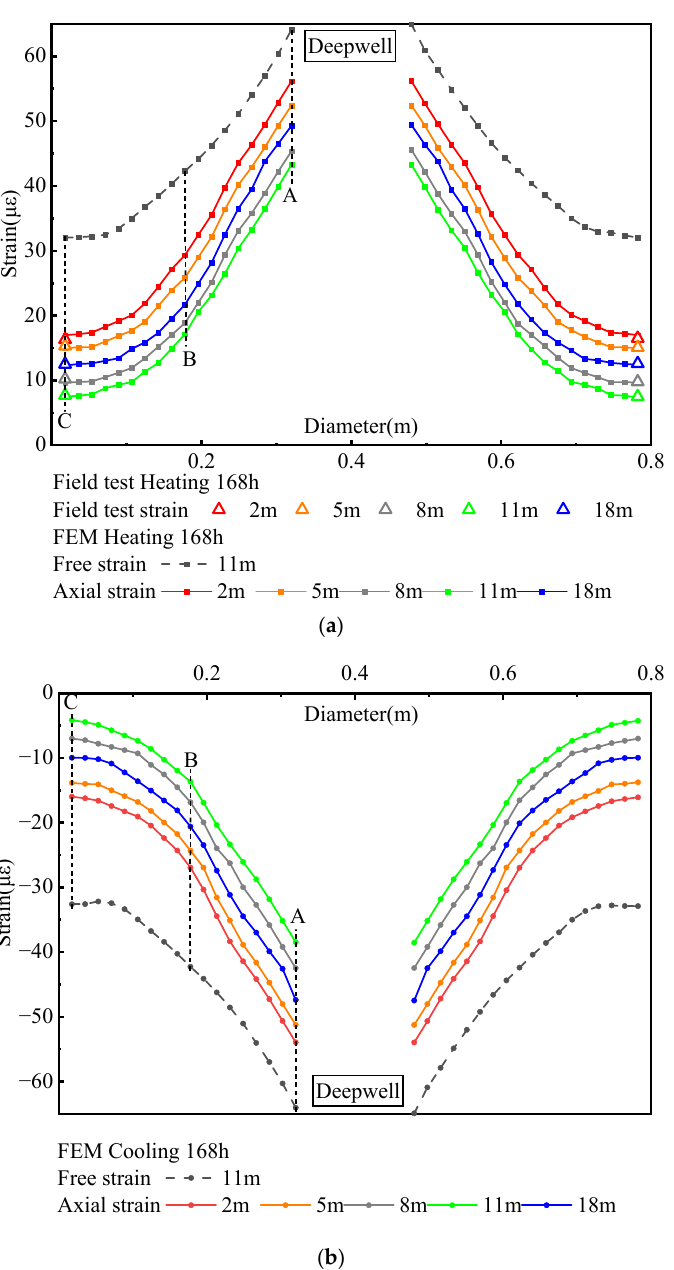
Figure 9. Axial strain distribution diagram in the radial direction at each depth of the pile: ( a ) heating condition; ( b ) cooling condition.